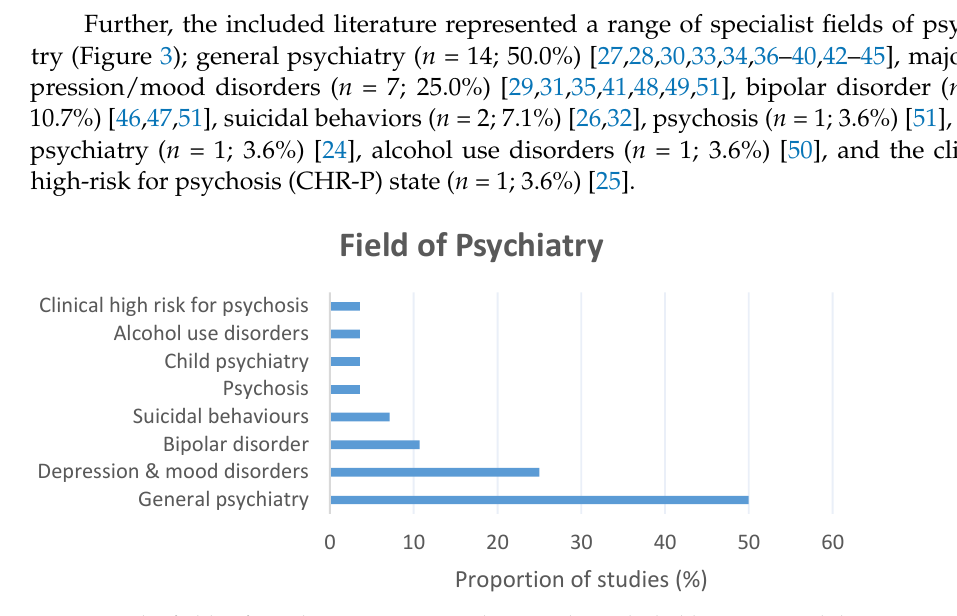
Figure 3. The fields of psychiatry investigated across the included literature and the proportion (%) of studies investigating each field.